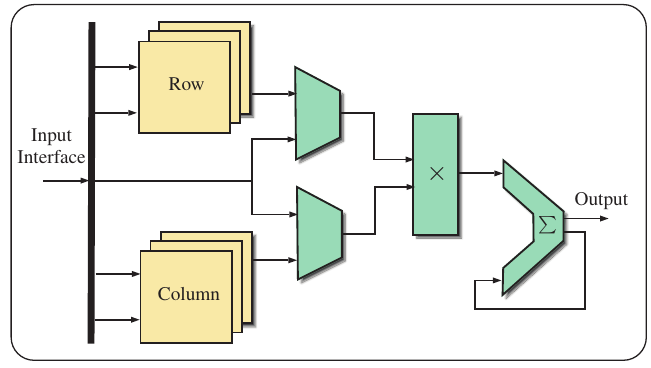
Figure 8. Matrix multiplier architecture.